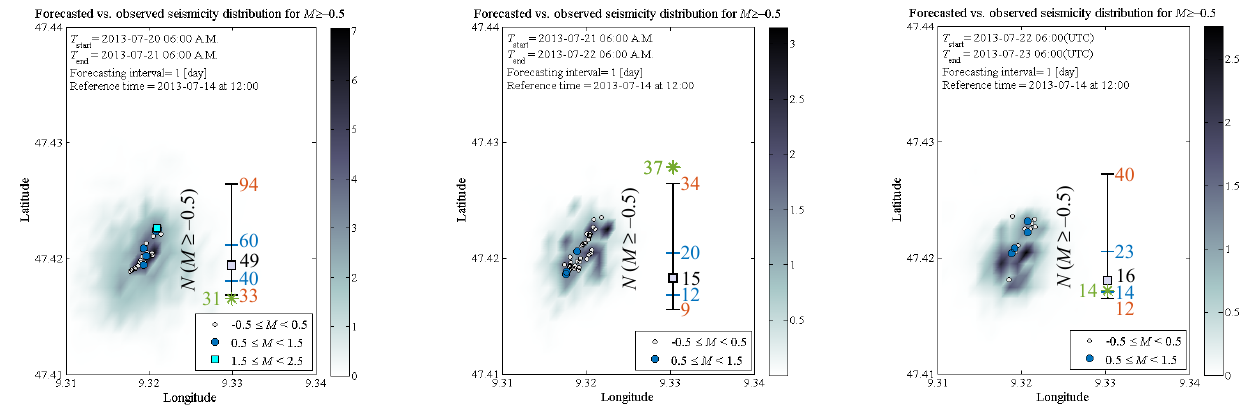
Figure 6. Forecasted versus observed seismicity distribution, the maps report the 98% confidence interval for the number of earthquakes per cell units (latitude/longitude cells of a 0.001°× 0.001° grid) with M L ≥ Mc = − 0.5, for 24 h forecasting intervals: (left) interval [ T start = 2013-07-20, T end = 2013-07-21]; (center) interval [ T start = 2013-07-21, T end = 2013-07-22]; (right) interval [ T start = 2013-07-22, T end = 2013-07-23]; The reference time interval is T o = 2013-07-14 at 12:00 UTC (the first event of the catalog occurred about 6 min after the reference time To). The observed (green star) vs. the error-bar is also shown for each sub-figure. The error bar is shown with the forecasted median value (the 50th percentile) labeled with a grey-filled square, the forecasted 16th and 84th percentiles (blue numbers), and the forecasted 2nd and 98th percentiles (red numbers). The error-bar for the forecasted number of events features: the median value (the 50th percentile, equivalent of the logarithmic mean in the arithmetic scale) marked with a grey- filled square; the (logarithmic) mean plus/minus one (logarithmic) standard deviation indicating the interval between 16th and 84th percentiles (marked with blue horizontal lines and numbered in blue); the (logarithmic) mean plus/minus two (logarithmic) standard deviations indicating the interval between 2nd and 98th percentiles (marked with black horizontal lines and numbered in red). This is done to help in locating the observed number of events (marked and numbered in green) within plus or minus certain number of standard deviations from the mean estimate. It can be seen that observed number